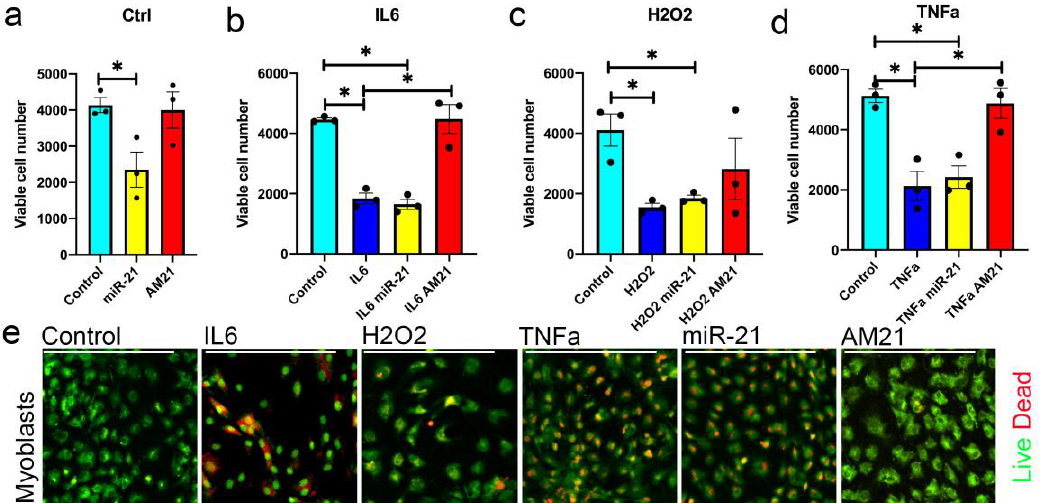
Figure 3. miR-21 regulates primary myoblast viability . ( a–d ) Myoblasts isolated from the adult mice were transfected with miR-21 mimic or inhibitor (AM21) and cultured in low serum media in the presence of 0.2 ng/mL interleukin 6 (IL6; b ), 50 µM H 2 O 2 ( c ) or 25 ng/mL TNFα ( d ) for 72 h, respectively. Cell metabolic activity indicative of cell viability was assessed via MTT assay. ( e ) Viable and dead myoblasts following transfections were visualised using live / dead staining (green—live cells, yellow / red—cells undergoing apoptosis / necrosis). Error bars show SEM, * p < 0.05 (compared to control), n = 3. Scale bar = 200 µm.